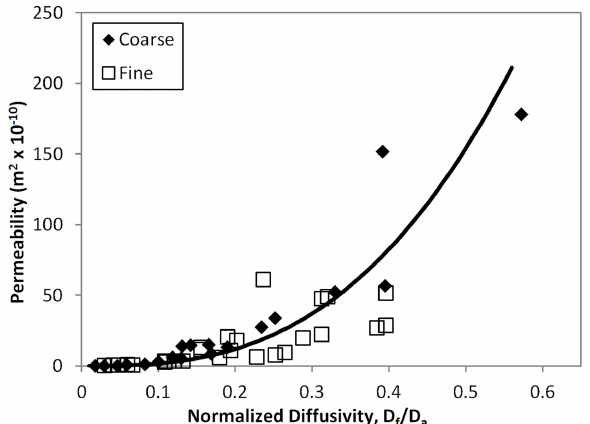
Fig. 8. Measured permeability vs. measured normalized diffusiv- ity. A best-fit relationship between the two parameters is shown as follows: k = 10 − 6 . 973 m 2